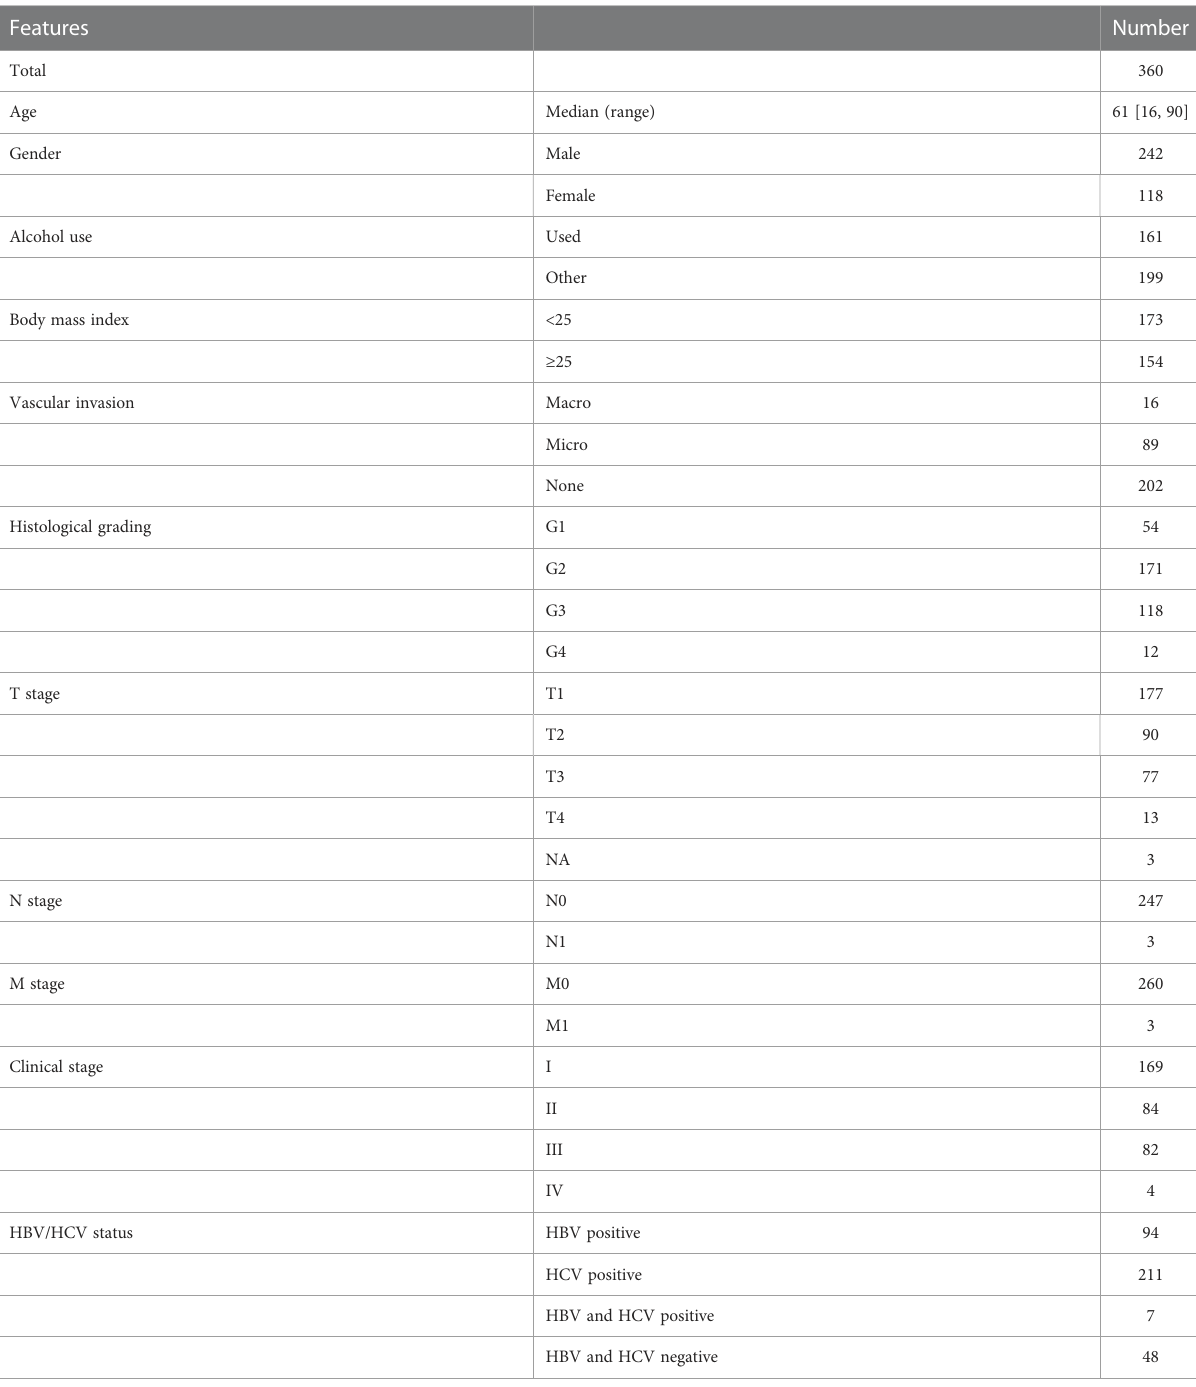
TABLE 1 Patient characteristics in TCGA-HCC